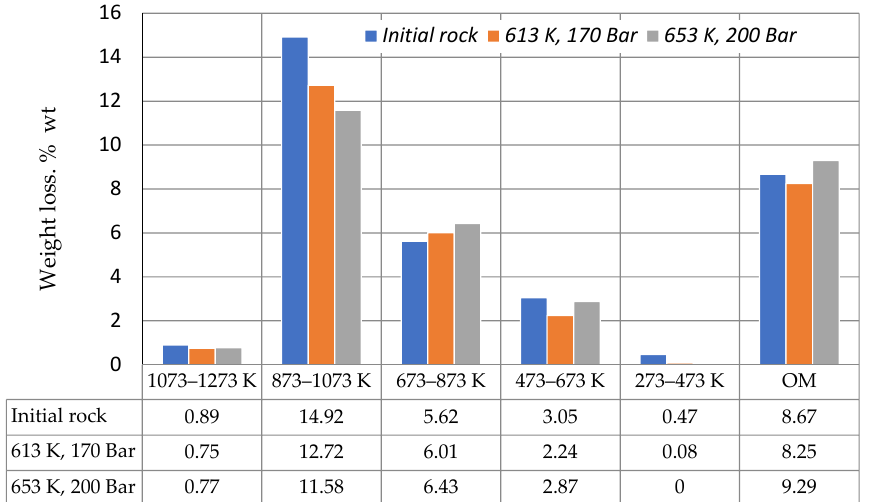
Figure 1. Weight loss of carbonate rock before and after experiments.